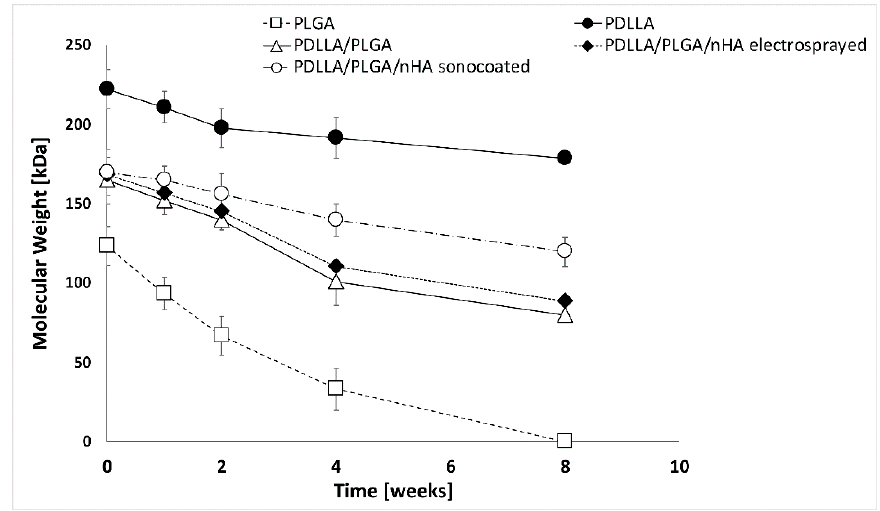
Figure 11. Graph of molecular weight (Mw) changes in the function of degradation time.